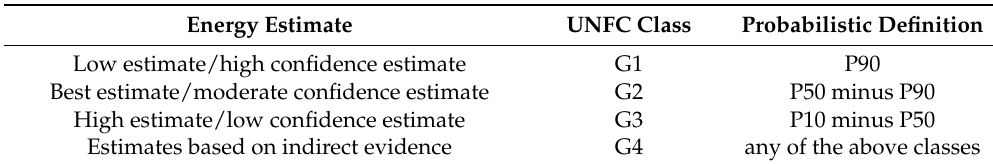
Table 1. Geologic uncertainty categories (G-axis definitions) of the United Nations Economic Commission for Europe (UNECE) geothermal resource